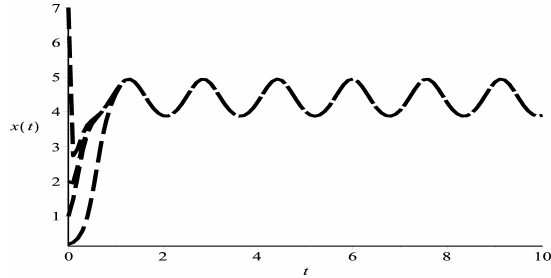
Fig. 3. Dynamic behavior of the first component x.t/ of the solution .x.t/;y.t// of system (61) with the initial conditions